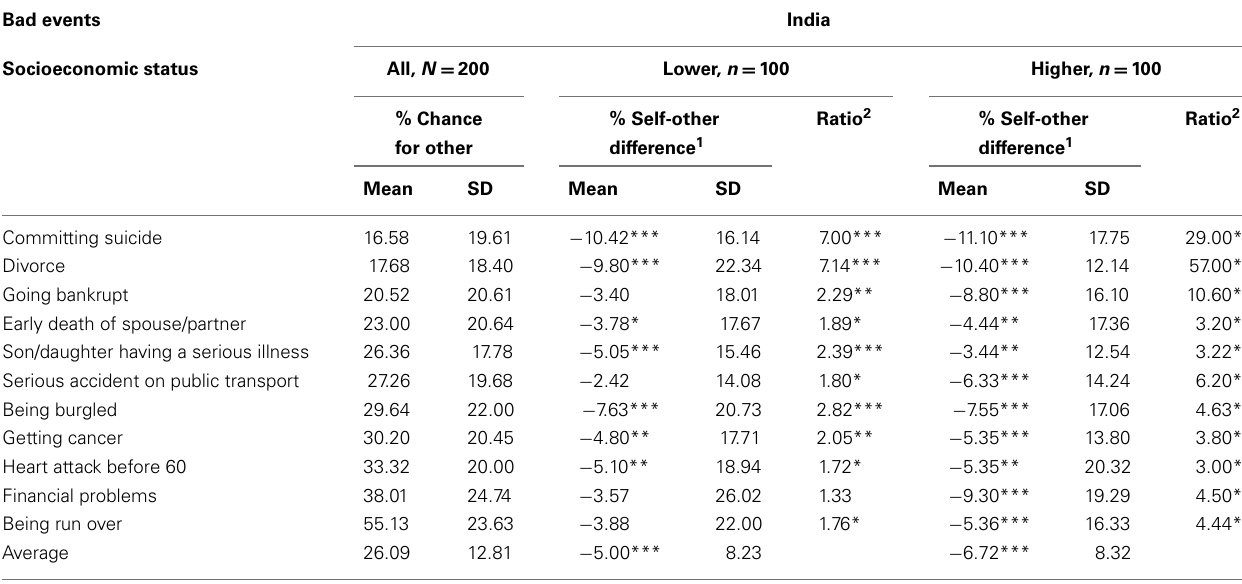
Table 2 | Bad events: comparative likelihood estimates, India. Bad events